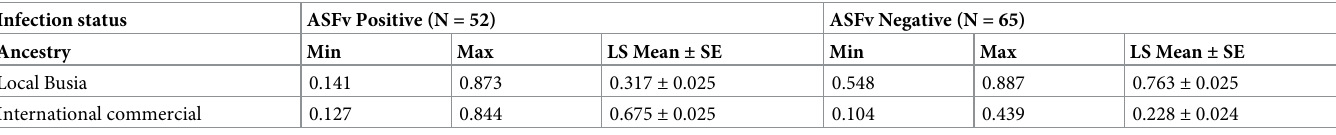
Table 3. Minimum, maximum and average (least squares means with associated standard errors) ancestry composition for domestic pigs in Busia evaluated for ASFv (N = 117). Infection